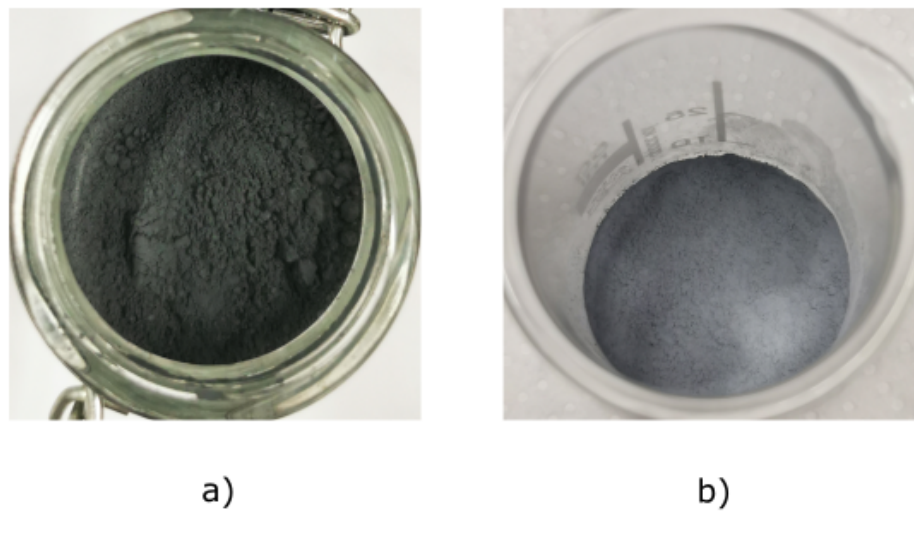
Figure A1. Particle images: ( a ) 40 nm and ( b ) 5 µ